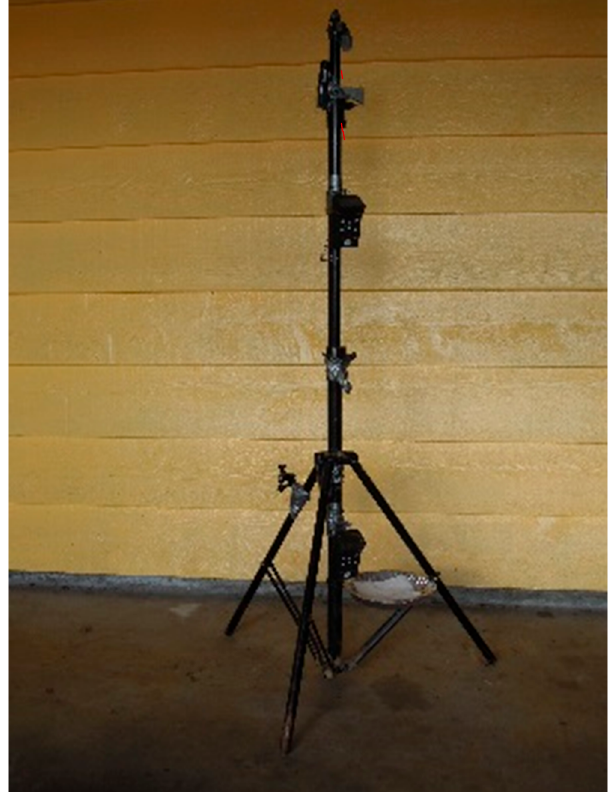
Figure 1. Instrument test stand. The photo shows the two instruments and the pie plate containing the paper towel.